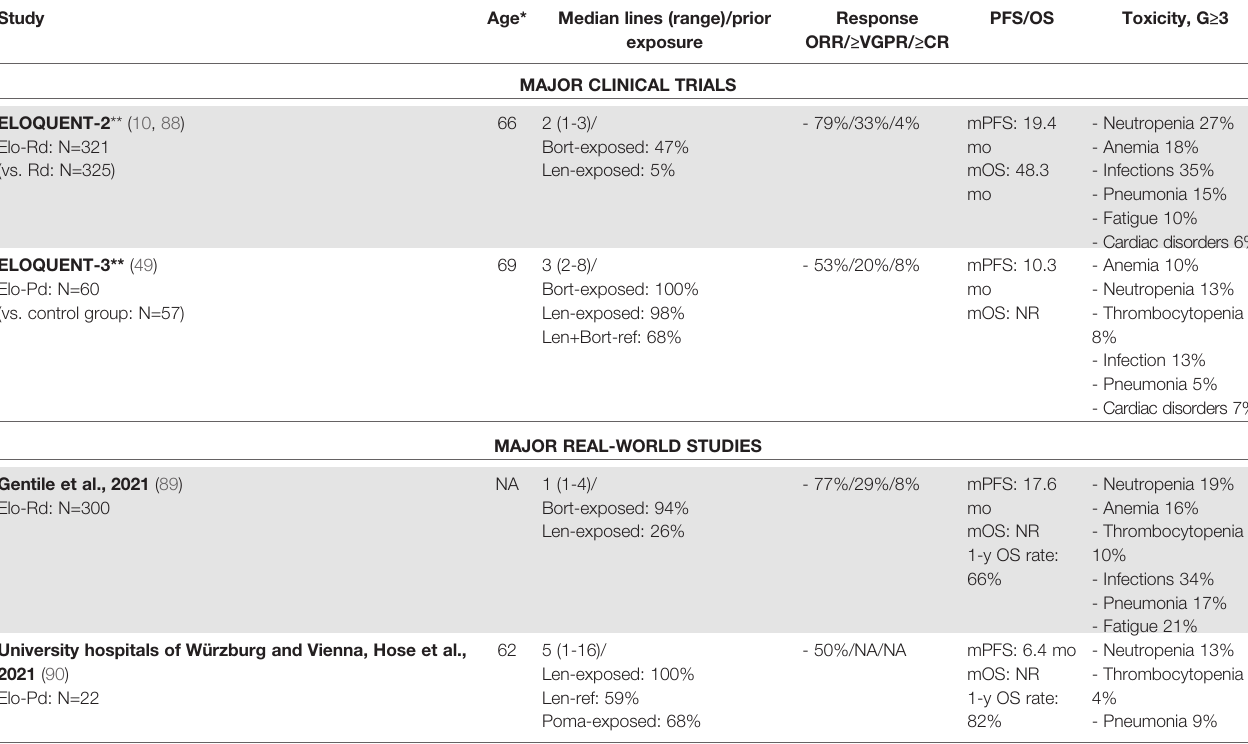
TABLE 6 | Major clinical trials and real-world studies based on elotuzumab for the treatment of RRMM. Study Age* Median lines (range)/prior